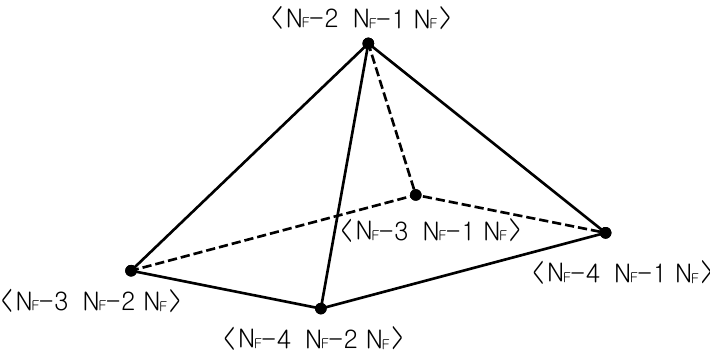
Figure 3 . Vertices, edges and triangular faces correspond to vacua, walls and three-pronged junctions. The parallelogram shaped base corresponds to two pairs of penetrable